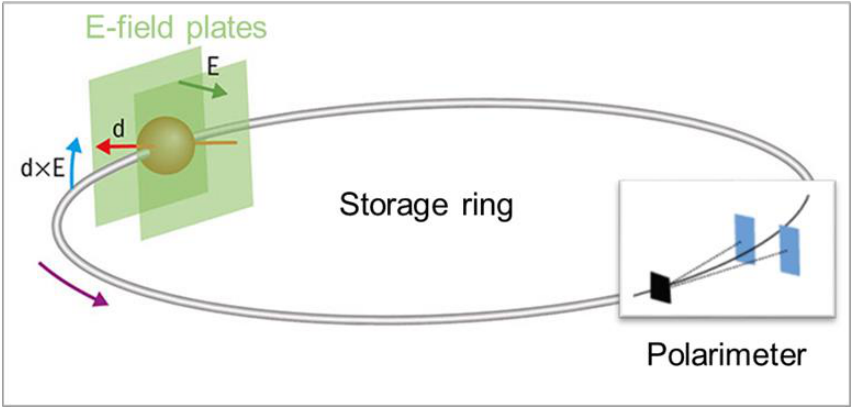
Figure 5. Basic principle of an EDM measurement. For clarity, only a single particle is shown and the magnetic moment precession is neglected. The particle is kept on its orbit by the transverse electric field E , generated by the electrostatic deflector plates that are depicted in green. Initially, all particle spins s in the beam point along the direction of motion. An electric dipole moment d = d s tilts the spin s out of the horizontal plane due to the torque d × E . This effect is experimentally observable, because the vertical polarization component of the beam can be detected in the polarimeter.